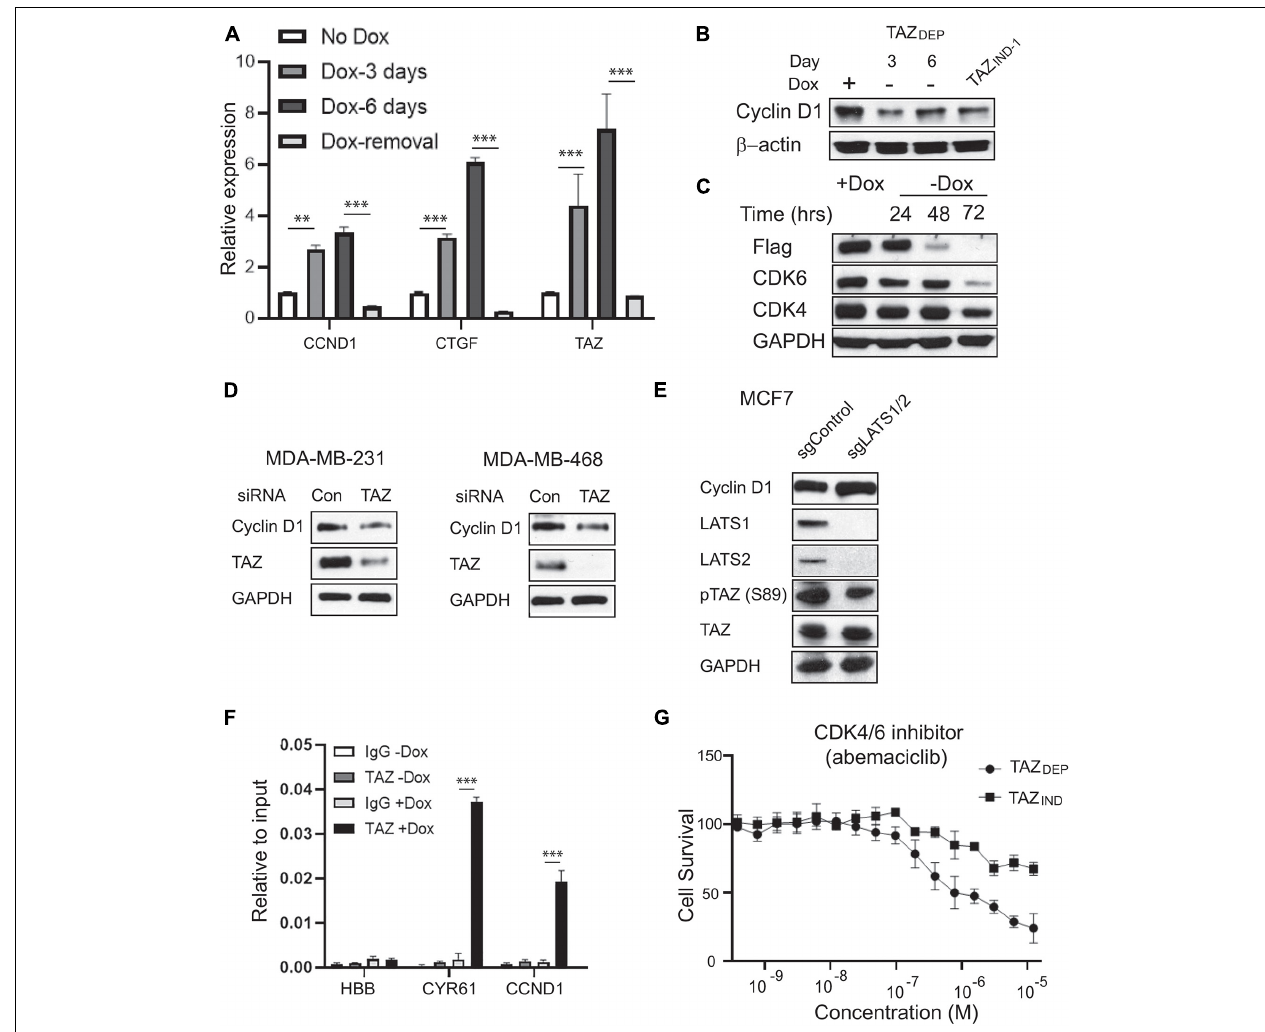
FIGURE 6 | Identification of CCND1 as a direct target of TAZ. (A) qRT-PCR experiment detection of CCND1, CTGF, and TAZ expression in TAZ DEP cells in response to dox treatment or dox removal. Relative expression was normalized by GAPDH expression. Unpaired two-tailed Student’s t -test: ∗∗ p < 0.01; ∗∗∗ p < 0.001. (B) Immunoblotting detection of CCND1 in response to dox withdrawal in TAZ DEP cells and TAZ IND cells. GAPDH was used as a loading control. (C) Immunoblotting detection of Flag-TAZ, CDK4, and CDK6 expression in response to dox withdrawal in TAZ DEP cells. GAPDH was used as a loading control. (D) Immunoblotting detection of TAZ and CCND1 in siControl or siTAZ transfected MDA-MB-231 or MDA-MB-468 cells. GAPDH was used as a loading control. (E) Immunoblotting detection of CCND1, LATS1, LATS2, TAZ, pTAZ (S89) in sgControl or sgLATS1/2 cells. GAPDH was used as a loading control. (F) qPCR experiment detection of TAZ-ChIPed DNA for CCND1. CYR61 was used as positive control; HBB was used as negative control. Relative enrichment was compared with 2% of input DNA. Unpaired two-tailed Student’s t -test: ∗∗∗ p < 0.001. (G) IC50 of CDK4/6 inhibitor Abemaciclib treatment. TAZ DEP cells grown in the presence of 2 µ g/ml